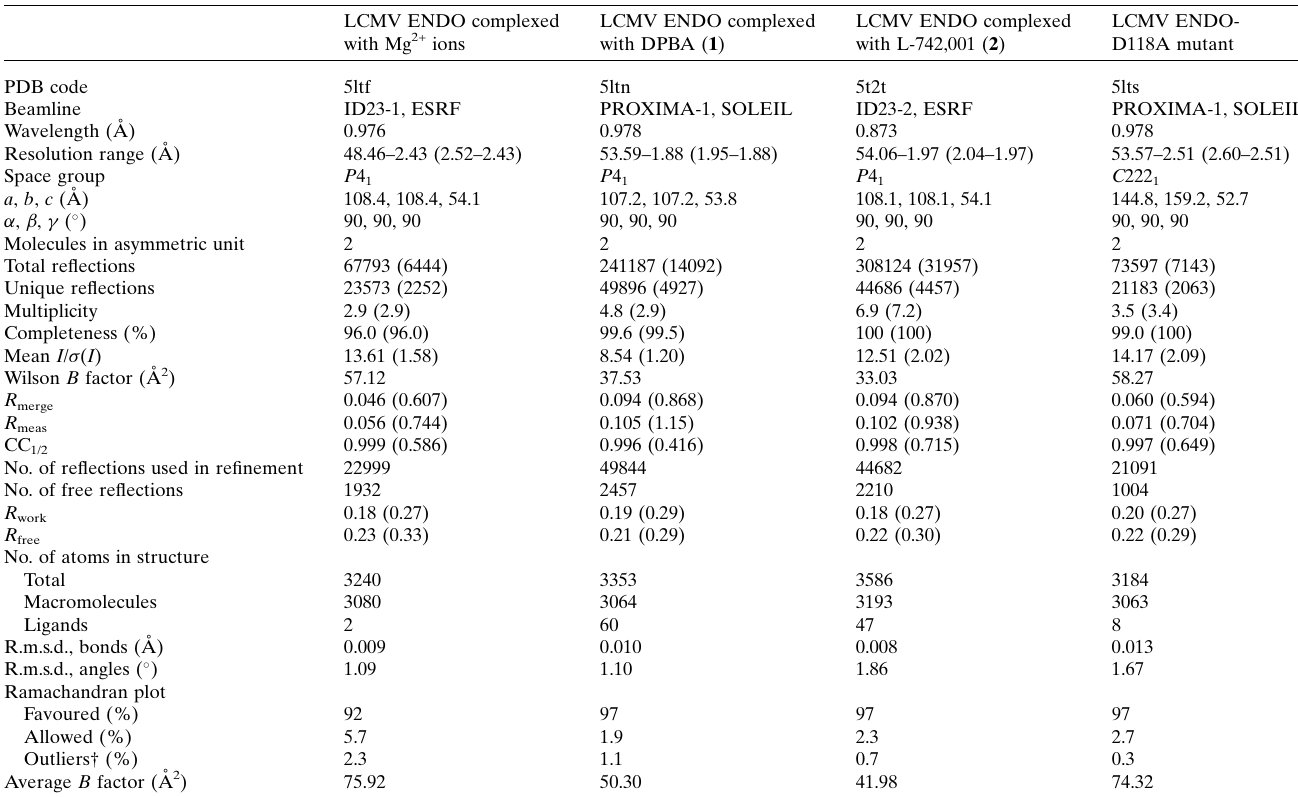
Table 1 Data-collection and refinement statistics for the LCMV endonuclease domain complexed with ions and compounds and for its D118A mutant. Values in parentheses are for the highest resolution